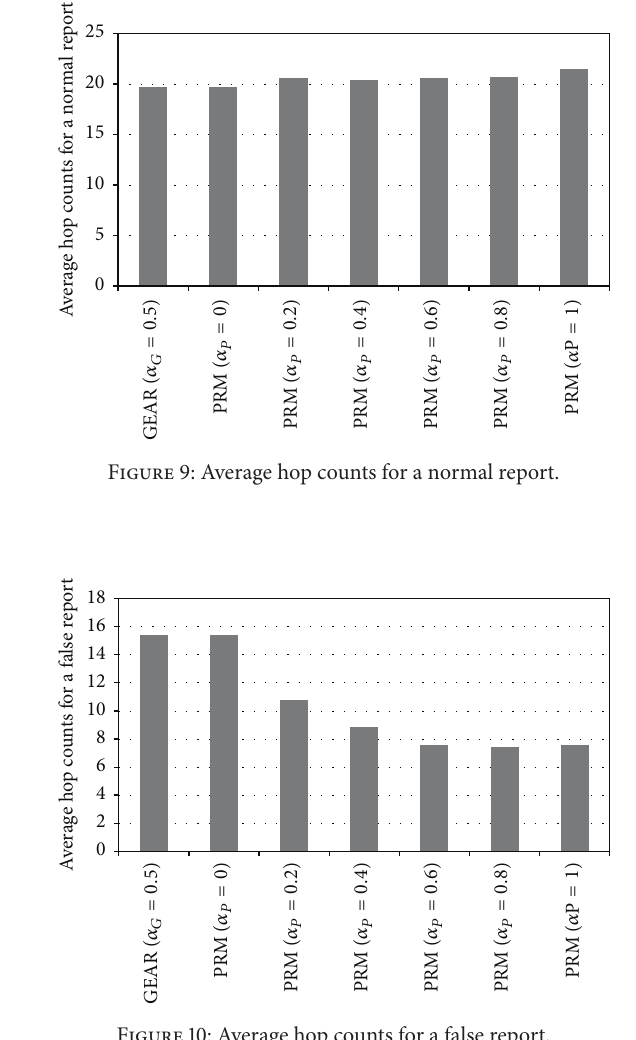
Figure 10: Average hop counts for a false